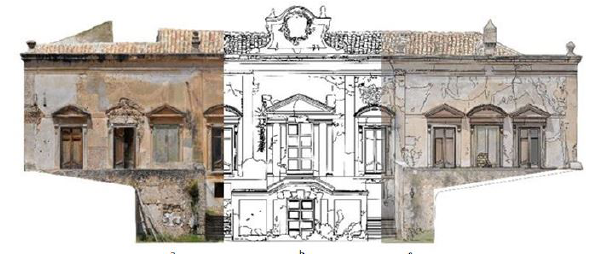
Figure 19. South-east façade: ortho-image and 2D drawing.